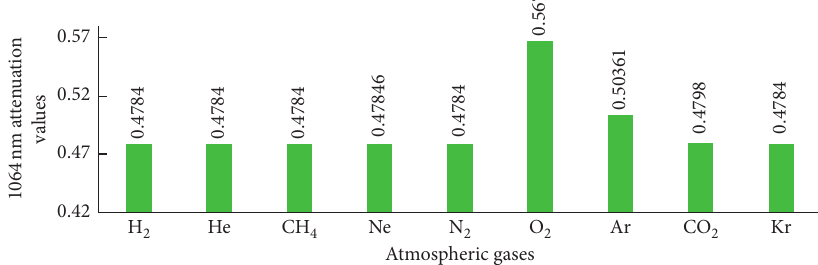
Figure 4: Attenuation values for